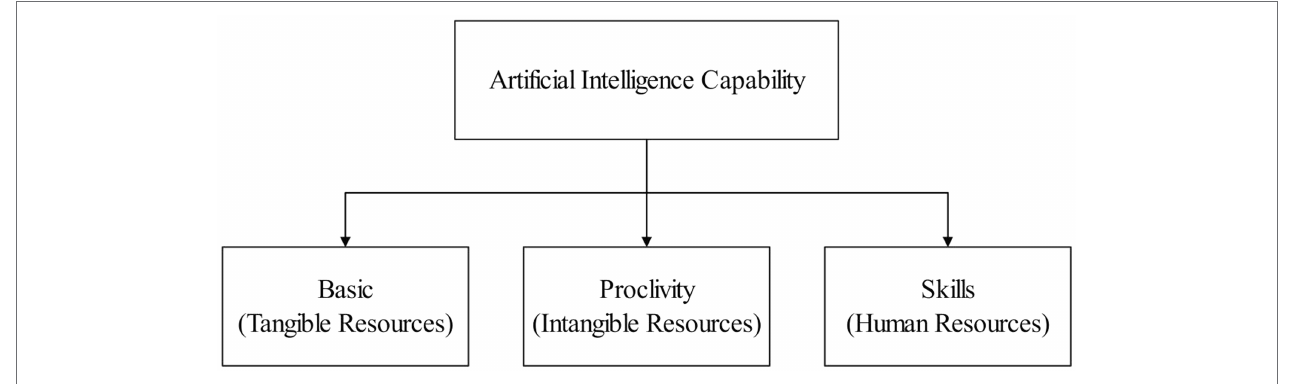
FIGURE 1 | Constructs of artificial intelligence capability (AIC) in e-commerce